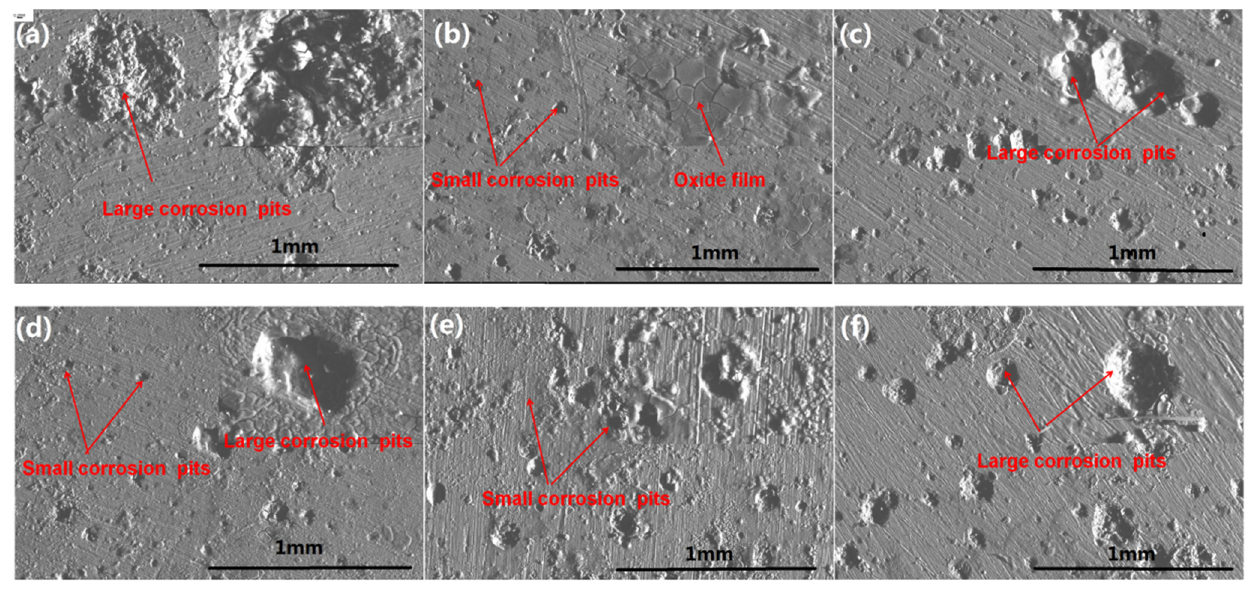
Figure 6. SEM images of surface morphologies for the six investigated anodes with different Ga percentages: ( a ) 0, ( b ) 0.01 wt%, ( c ) 0.02 wt%, ( d ) 0.03 wt%, ( e ) 0.04 wt% and ( f ) 0.05 wt%.